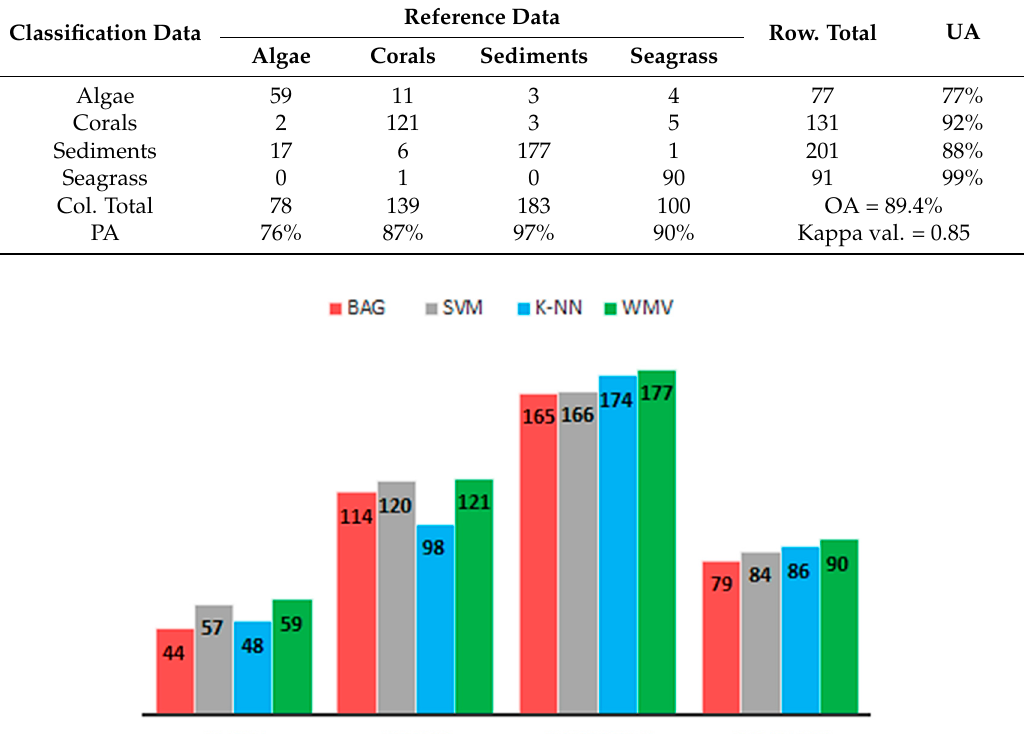
Figure 7. The amount of correct features detected from each classifier for benthic habitats detection.